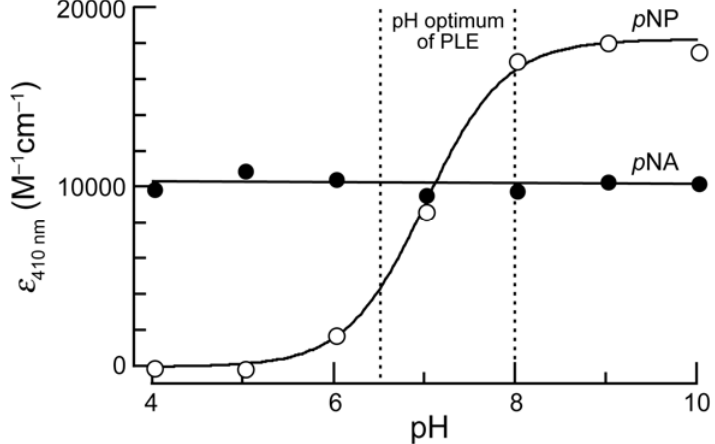
Figure 1. pH-Sensitivity of the extinction coefficients at 410 nm of p -nitroaniline ( p NA) and p -nitrophenol ( p NP). Measurements were made in triplicate in PBS adjusted to the appropriate of p NP was pH. The observed p K a